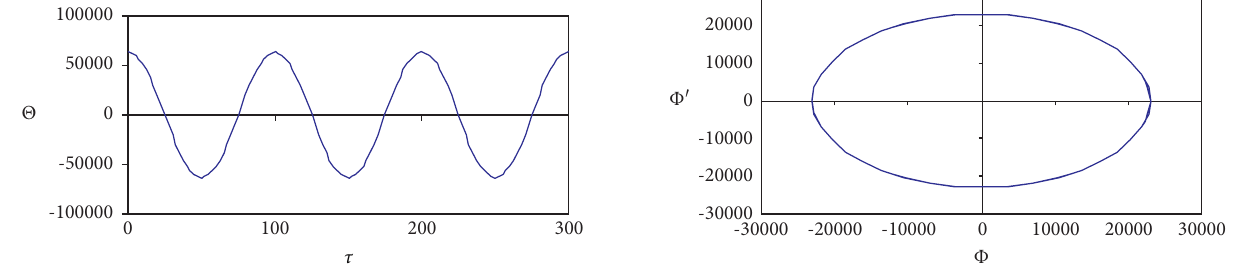
Figure 15: The analytical solution Θ for case (i) in Section 4.2.